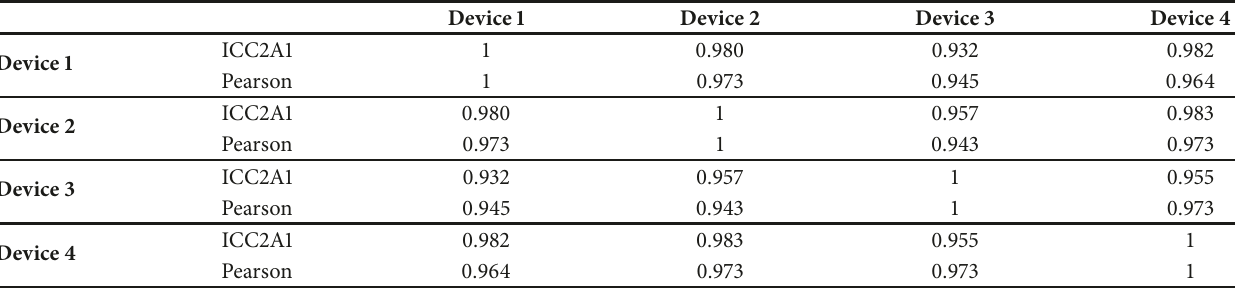
Table 4: BiliCare (cid:2) interapparatus